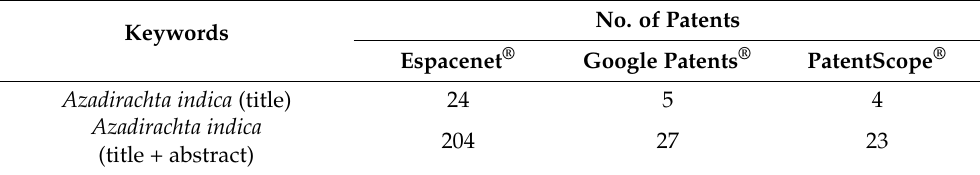
Table 2. Patents found in 3 databases with the keywords Azadirachta indica in the title or